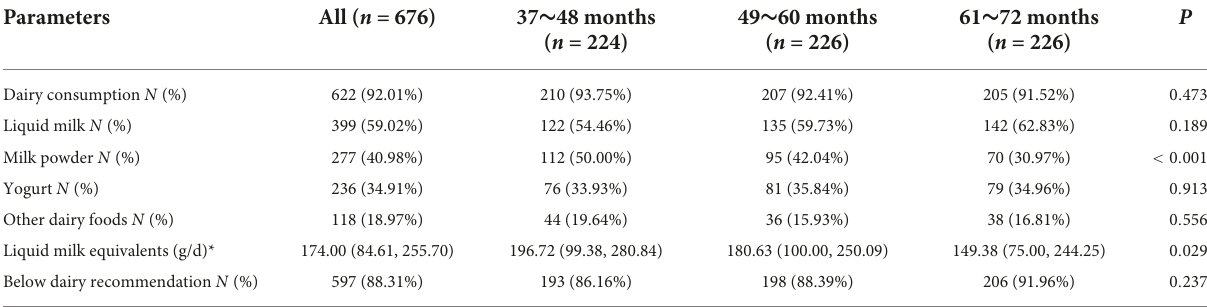
TABLE 1 Dairy intakes before